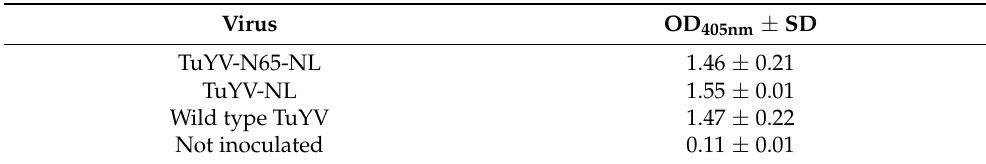
Figure 2. Western blot analysis of ( A ) Montia perfoliata and ( B ) Nicotiana benthamiana leaves agro ‐ infiltrated with TuYV ‐ N65 ‐ NL, TuYV ‐ NL, with wild ‐ type TuYV (TuYV ‐ WT) or mock ‐ inoculated (M). Two acrylamide gels were loaded in parallel with total protein extracts. Proteins from the first gel were transferred onto a nitrocellulose membrane and incubated with a mix of antibodies raised against the TuYV coat protein (CP) or the readthrough protein (RT). The second gel was stained with Instant Blue solution, and the large RubisCO unit is shown as a loading control. *, different cleavage products of the RT protein; positions of the molecular markers (in kDa) are indicated on the left. Table 1. Detection by double antibody sandwich ‐ ELISA of TuYV ‐ N65 ‐ NL and TuYV ‐ NL in inoculated leaves of Nicotiana benthamiana . Two plants were analyzed for inoculated conditions and three for non ‐ inoculated conditions.